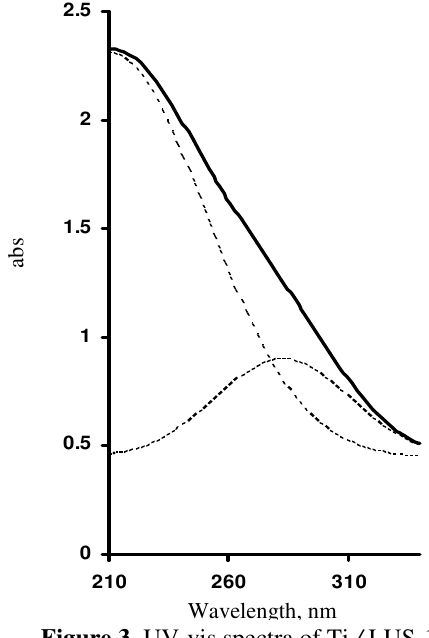
Figure 3. UV-vis spectra of Ti / LUS-1